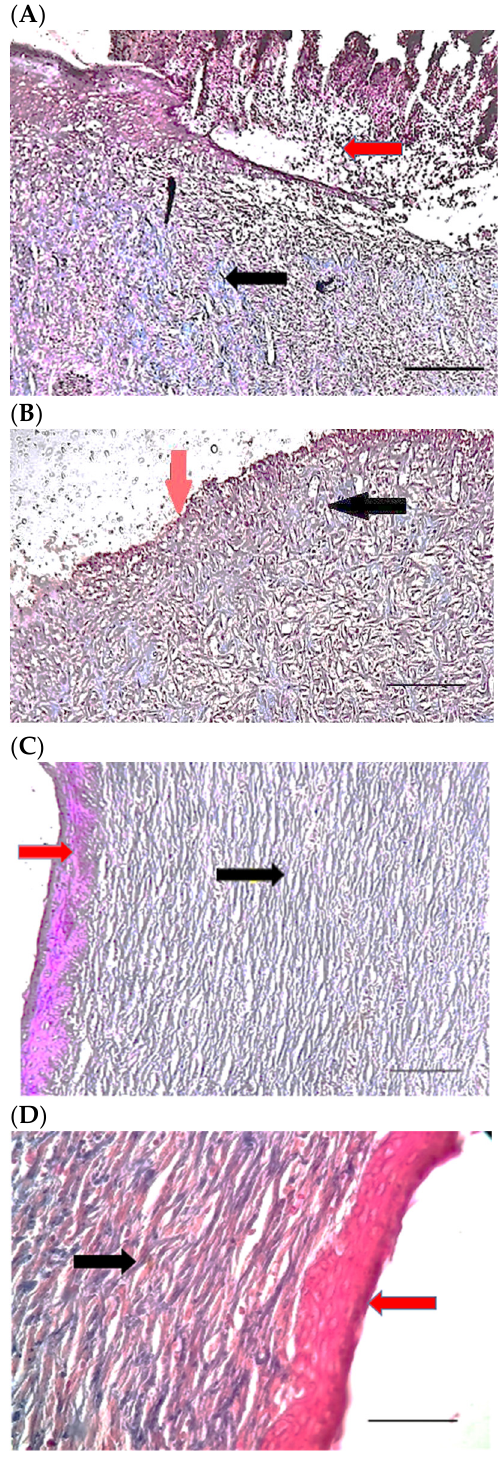
Figure 11. Mason trichrome stained microscopic sections (Bar = 50μm) wound in rats on day 21 of the study. ( A ) Control group; Incomplete re-epithelialization (red arrow), collagen fibers (black arrow). ( B ) Ch group; Incomplete epithelium formation (red arrow), scattered collagen fibers (black arrow). ( C ) ChSeN group; Re-epithelialization (red arrow), collagen fibers (black arrow). ( D ) ChSeND group; Good re-epithelialization (red arrow), relatively thick collagen fibers (black arrow).